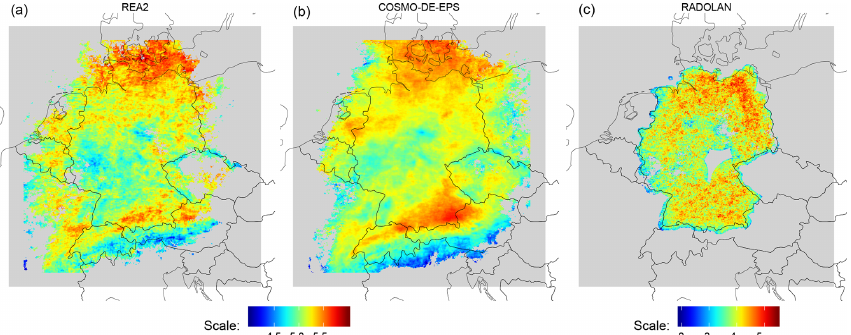
Figure 5. Map of central scales, averaged over all instants with non-zero precipitation for COSMO-REA2 (a) , COSMO-DE-EPS ( b , aver- aged over all 20 members) and RADOLAN ( c , individual colour bar). Pixels with fewer than 21d with precipitation were discarded. The RADOLAN mask was not applied to REA2 and